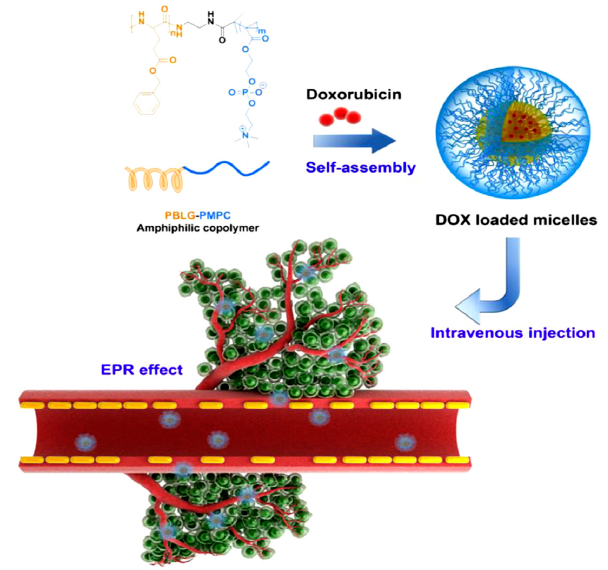
Figure 3. Self-assembly, drug loading and tumor accumulation of PBLG- b -PMPC polymeric micelles. Reference